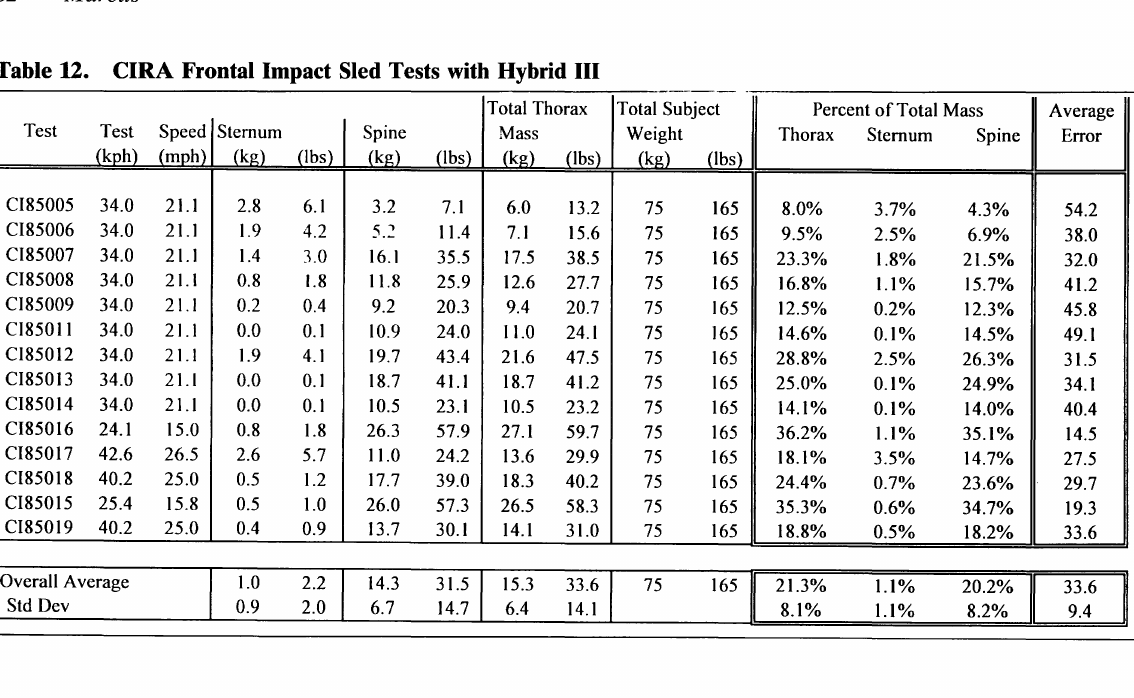
Table 12. CIRA Frontal Impact Sled Tests with Hybrid